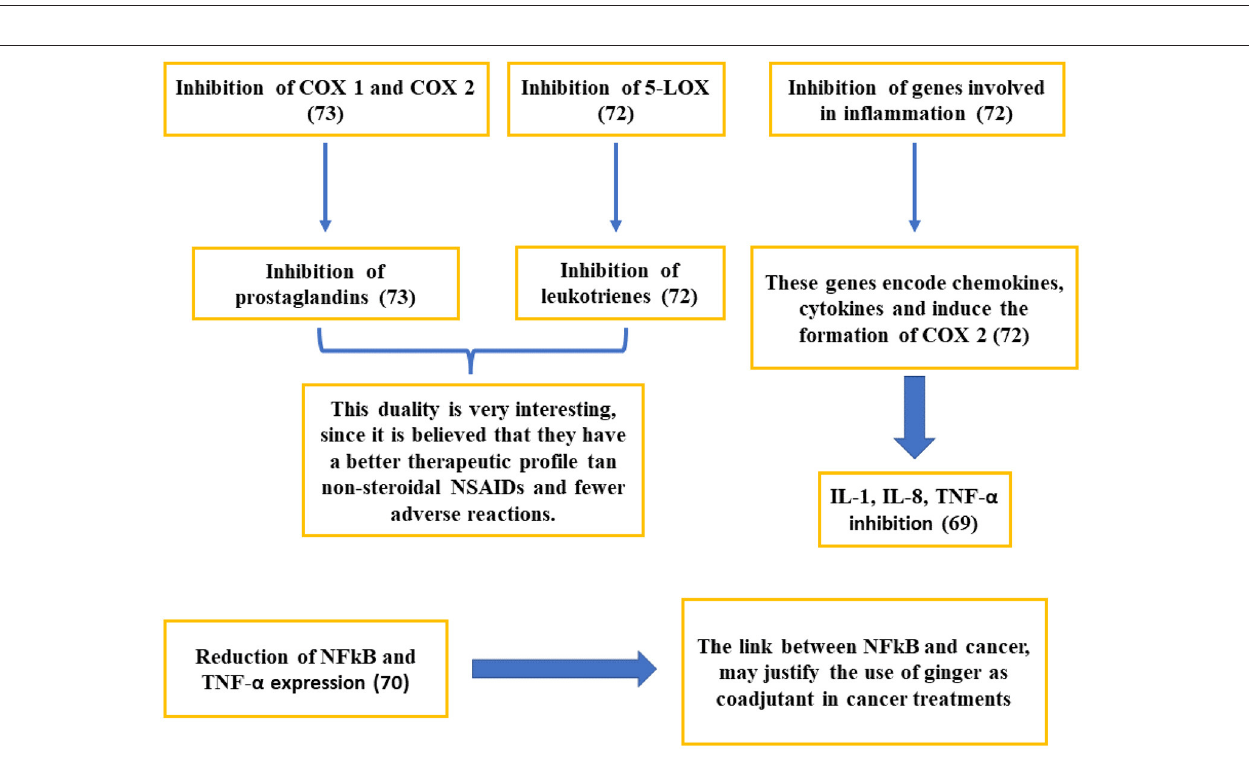
FIGURE 4 | Studies on the mechanisms of action related to the anti-inflammatory activity of ginger.